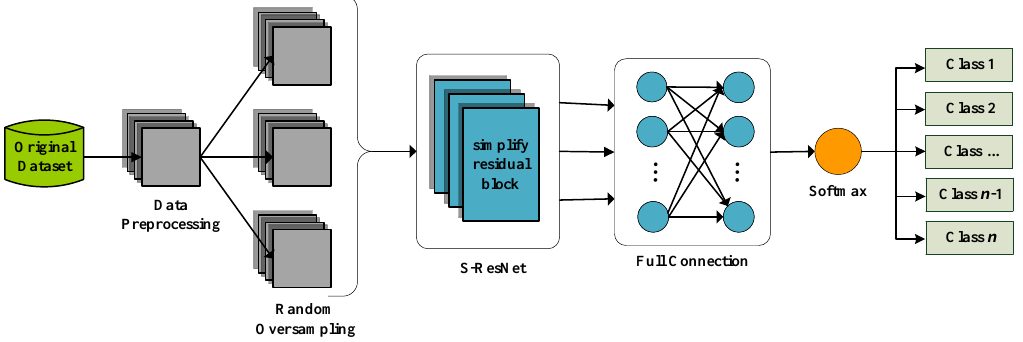
Figure 4. The intrusion detection system (IDS) based on the simplified residual network (S-ResNet).